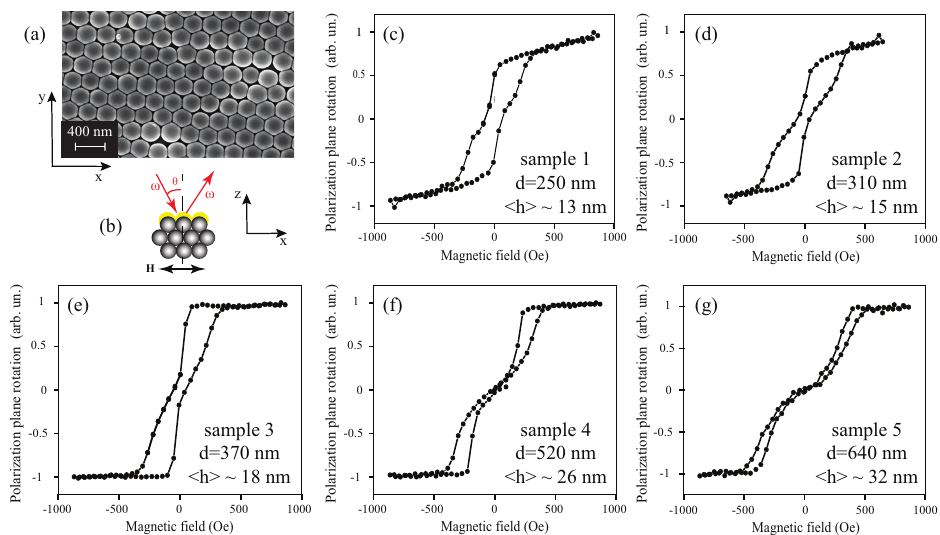
Figure 1. ( a ) SEM image of the surface of the Co-opal sample “1” with the diameter of the spheres d = 250 nm; ( b ) scheme of the longitudinal MOKE measurements (yellow color is for Co coating); ( c – g ) MOKE hysteresis loops for the samples “1”–“5”, respectively, the diameter of the spheres d , and the average thickness of cobalt are indicated on the